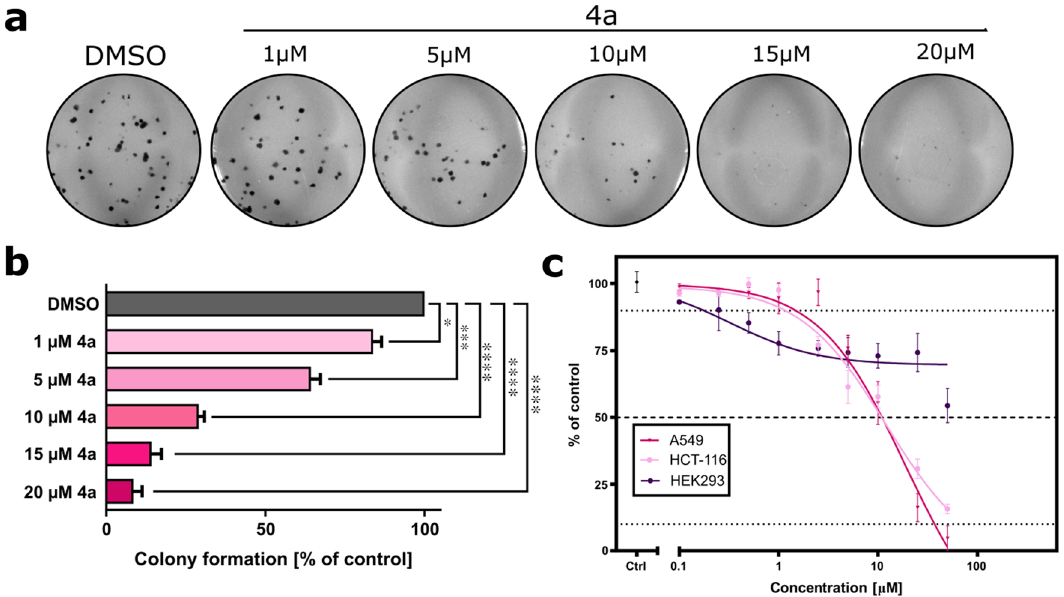
Figure 3. Effect of 4a on colony formation and cell viability. ( a ) Representative photos of the colony formation assay after the treatment of A549 cells with increasing concentrations of 4a . ( b ) Quantification of the colony formation assay. ( c ) Effect of 4a on cell viability after incubation with compound for 72 h. Data represent the mean ± SEM of n = 3 independent experiments. * p < 0.01, ** p < 0.001, *** p < 0.0001, and **** p <